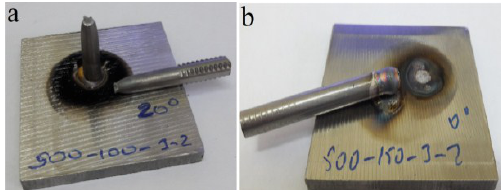
Figure 8. Fractured samples after tensile tests.